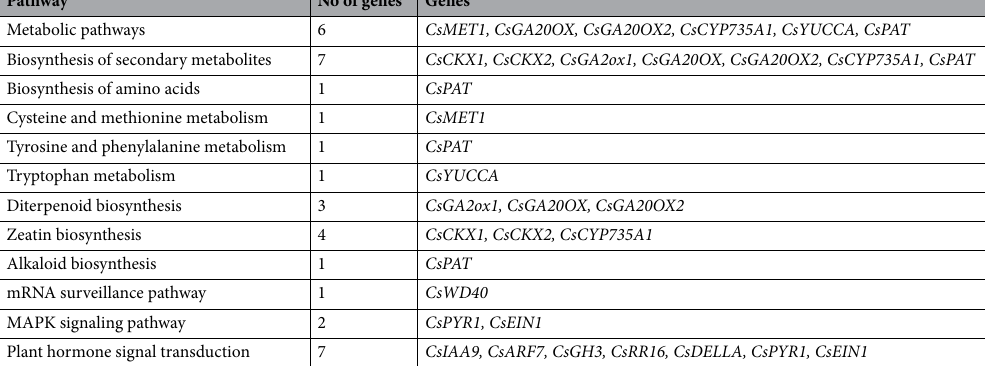
Table 3. KEGG pathway analysis of genes from predicted to be involved in